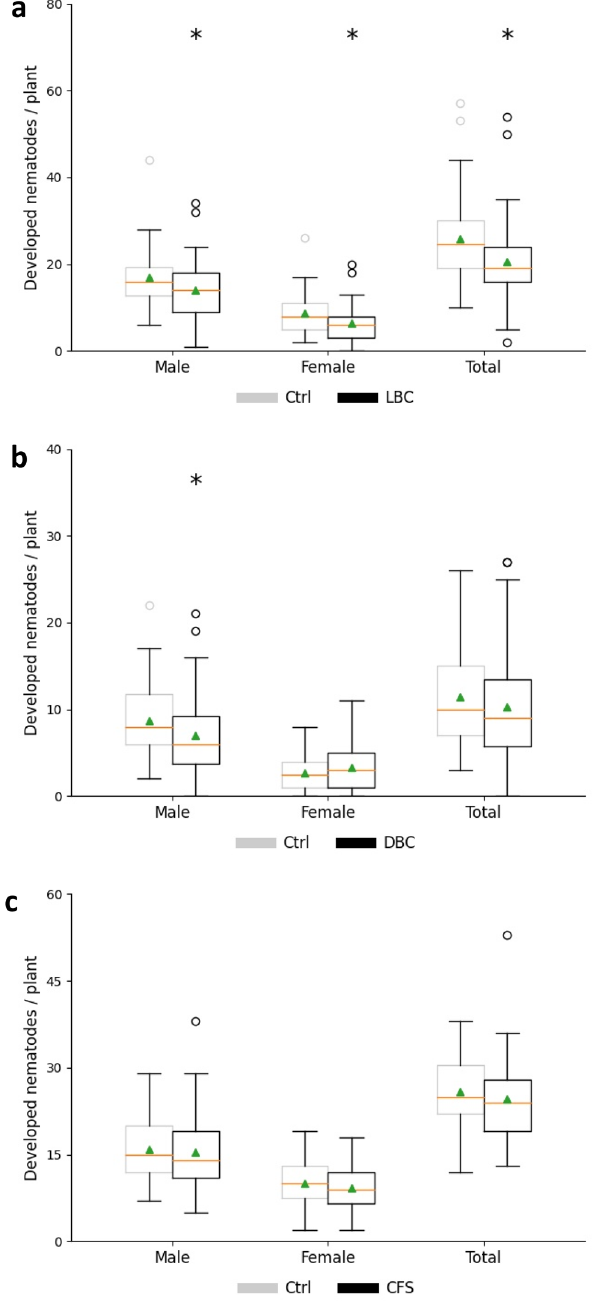
Figure 4. Infection assay of Heterodera schachtii at Arabidopsis thaliana roots. Average number of nematodes per plant at 14 dpi (days post inoculation) in the presence of LBC ( a ), DBC ( b ) or CFS ( c ). LBC living bacterial cells, DBC dead bacterial cells, CFS cell-free supernatant. Results are expressed as the mean (orange line) and median (green triangle) ± standard error of three independent biological replicates (n ≥ 40). Data are statistically analysed using Dunn’s Method. Asterisk (*) indicate statistically significant differences compared with the control ( p <